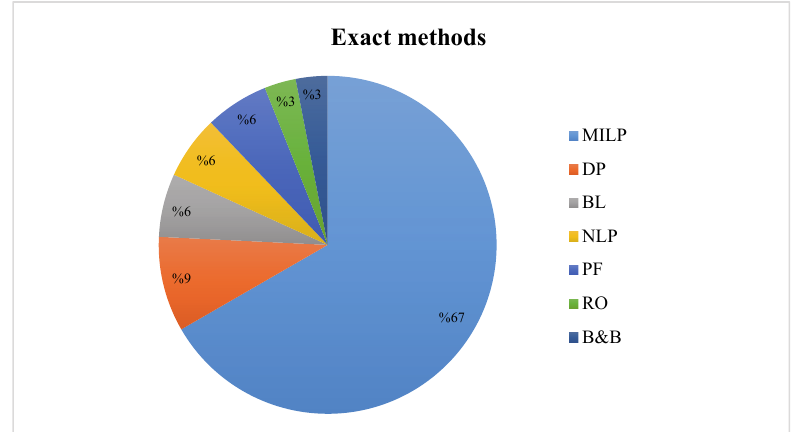
Fig. 7. Distribution of exact solution